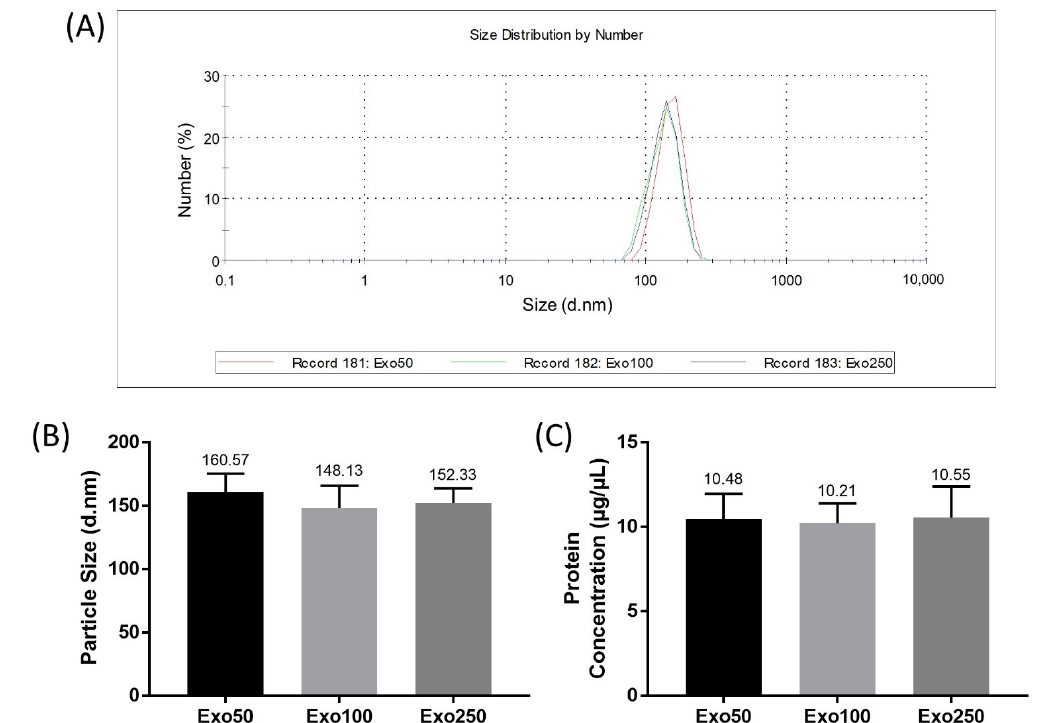
Figure 5. Exosome characterizations. Size distribution of Exo50, 100, and 250 based on a nanoparticle size analysis ( A ). Exosomes isolated from 50, 100, and 250 were shown in different colors. The blue line, green line, and red line are for Exo50, Exo100, and Exo250, respectively. The comparison of the exosome sizes ( B ). All isolated exosomes showed sizes in the range of the exosome sizes. Protein concentration of the isolated exosomes ( C ). Data are the mean of three independent experimental replicates (±SEM). One-way ANOVA revealed no significant differences among the isolated exosomes in terms of the particle size and protein concentration ( p > 0.05).